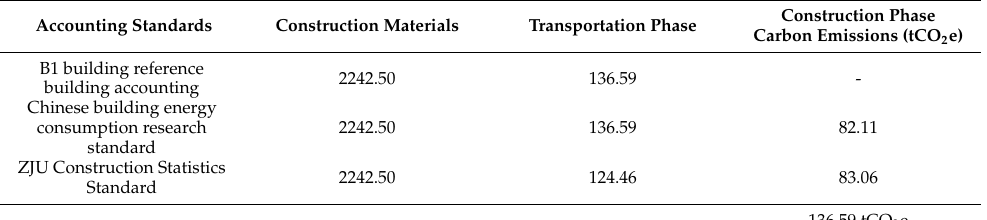
Table 19. Calculation of carbon emissions of B1 building construction by casting-in-place